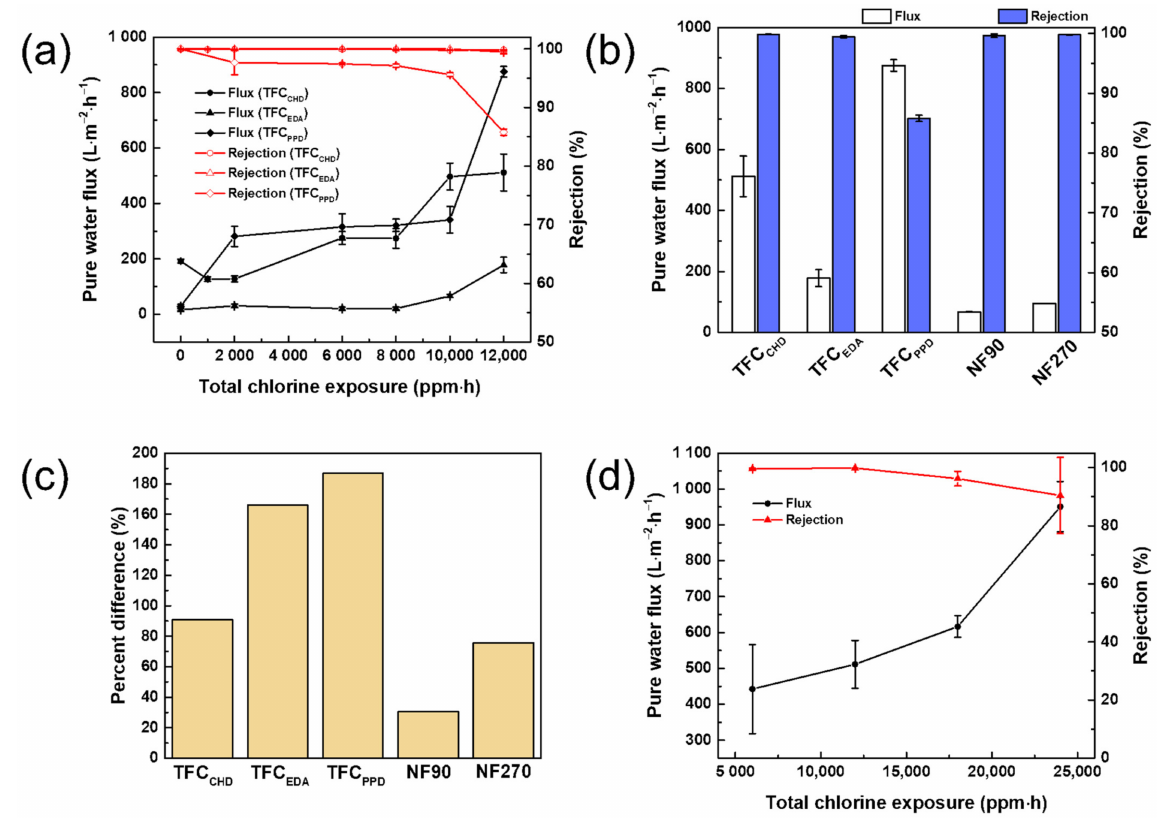
Figure 7. ( a ) Performance of TFC membranes at different chlorine exposure and ( b ) comparison of the chlorine resistances of the TFC membranes in this work with commercial membranes (total chlorine exposure = 12,000 ppm · h). ( c ) Percent difference before and after chlorine exposure of the membranes (total chlorine exposure = 12,000 ppm · h). ( d ) Effect of chlorine concentration (exposure time = 6 h) Amine monomer concentration = 0.15 wt%; TMC concentration = 0.2